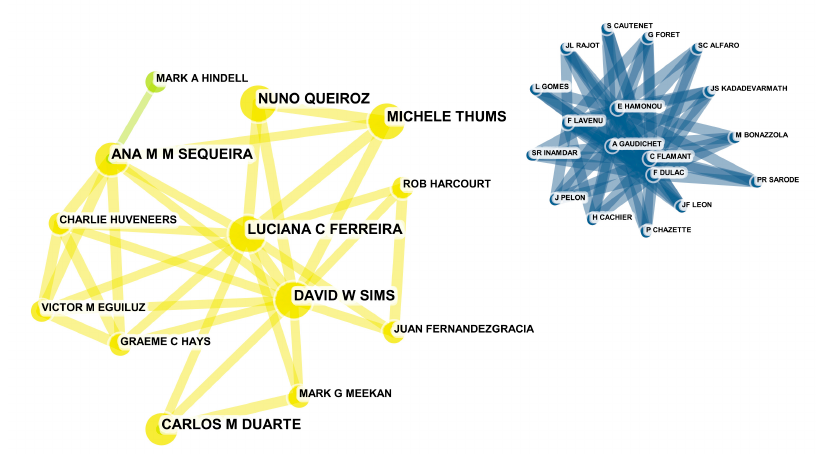
Figure 5. Author collaboration network map. Table 3. Top 10 most productive authors of big ocean data documents.